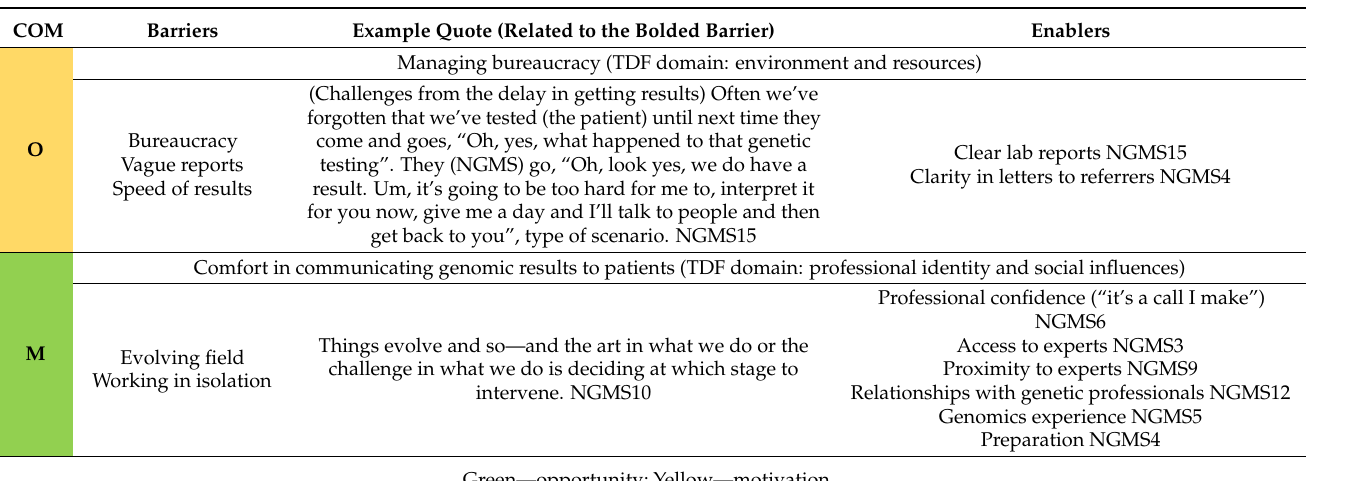
Table 4. Target behaviour area 3, grouped barriers coded by the Theoretical Domains Framework and Capability, Opportu- nity and Motivation Behaviour framework. Detailed information about the barriers and enablers reported for each grouped barrier can be found in the Supplementary Files (Supplementary Table